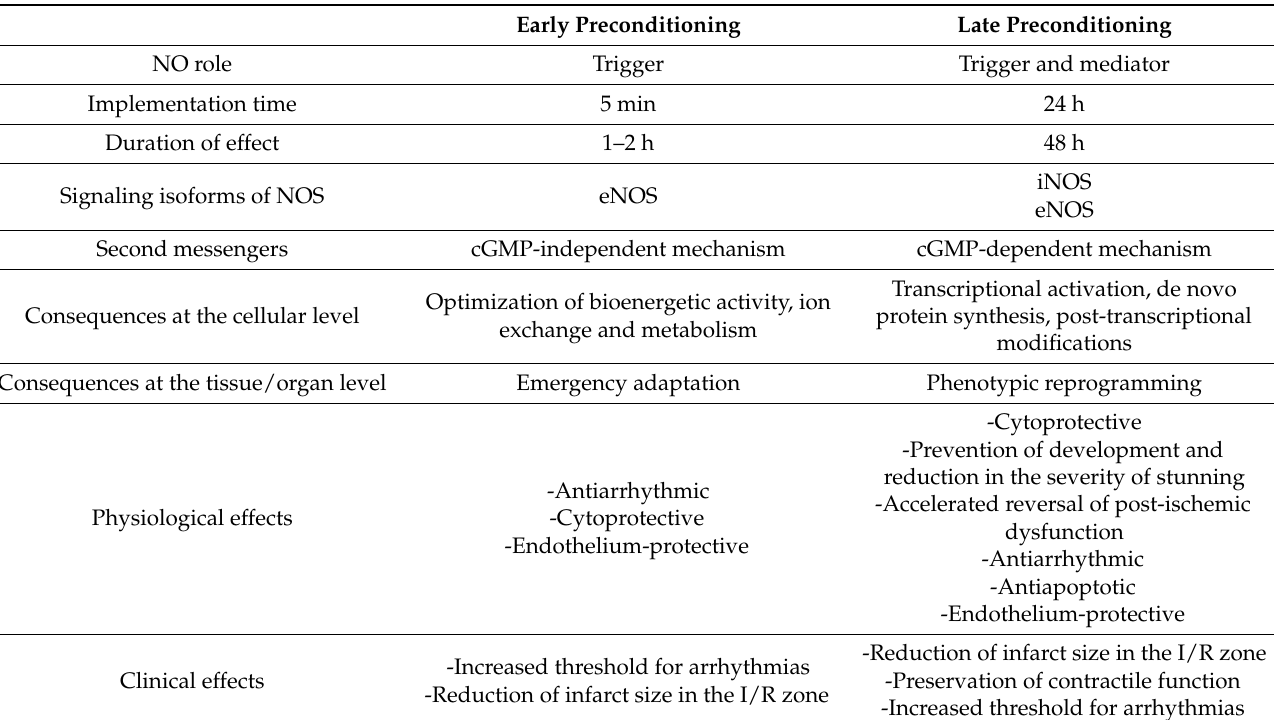
Table 1. Nitric oxide (NO) in the implementation of early and late preconditioning phenomena. A comparison of the NO role in early and late